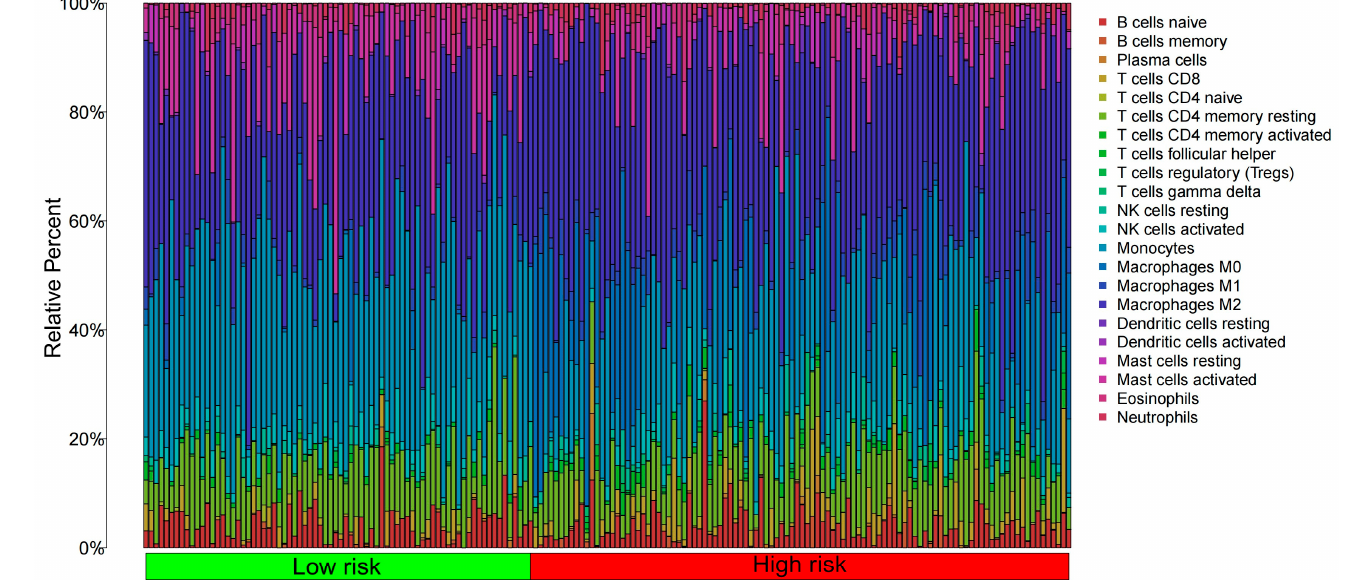
Figure A4. The relative infiltration percentages of immune cells of patients with glioma from the TCGA cohort.